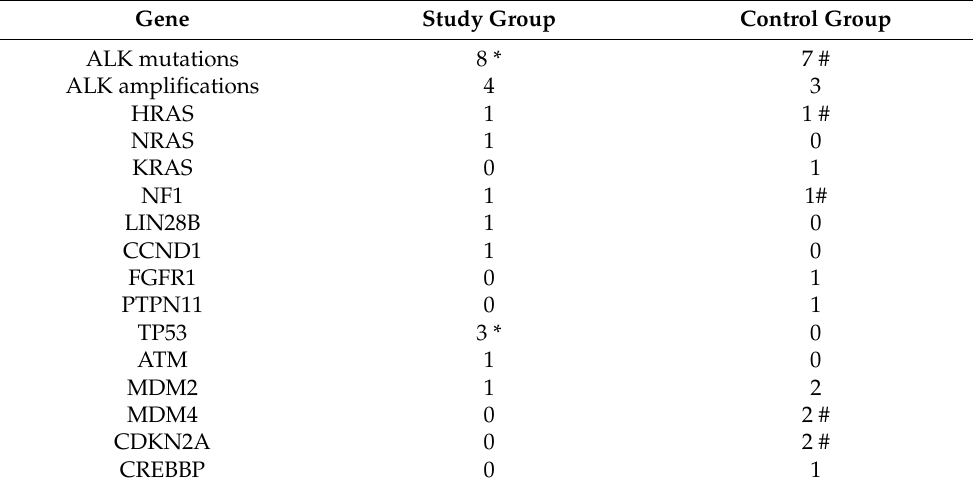
Table 2. Type of mutations in the study group ( N = 22 in 21 patients) and the control group ( N = 22 in 19